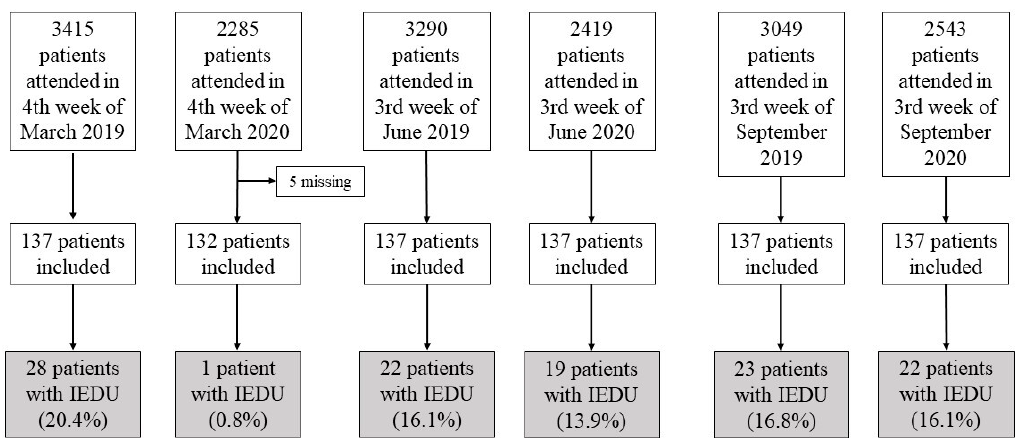
Figure 1. Flow diagram. IEDU: Inappropriate use of the emergency department.